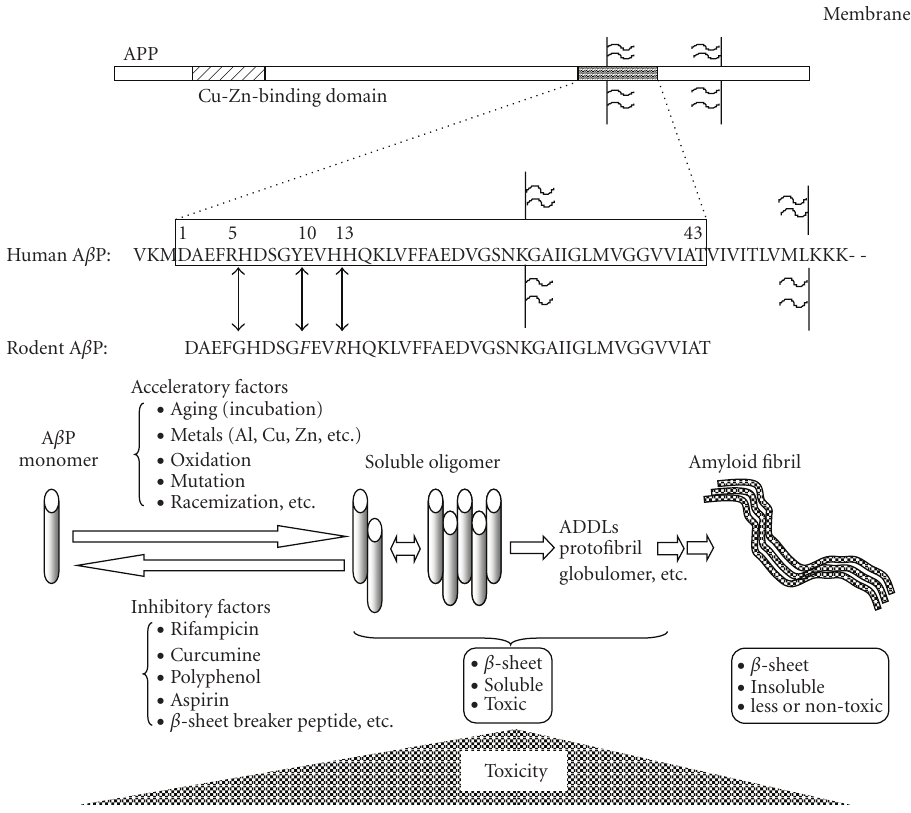
Figure 3: Secretion of A β P from APP and its oligomerization. A β P is secreted by the cleavage of the APP N-terminus by β -secretase (BACE), followed by the intramembrane cleavage of the C-terminus by γ -secretase. APP also binds to Cu or Zn. Human A β P and rodent A β P di ff er by 3 amino acids (Arg 5 , Tyr 10 , and His 13 ). A β P monomers form random-coil structures. However, under aging conditions or the existence of trace metals such as Al, Zn, and Cu, A β P self-aggregates and oligomerizes (dimmer to protofibrils), and then forms insoluble amyloid fibrils. Although monomeric A β Ps are not toxic, oligomeric A β Ps induce marked neuronal